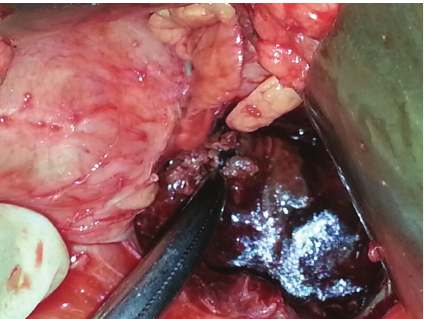
Figure 5: Per operative photograph of the patient showing lesser sac with pseudoaneurysm and necrosed part of